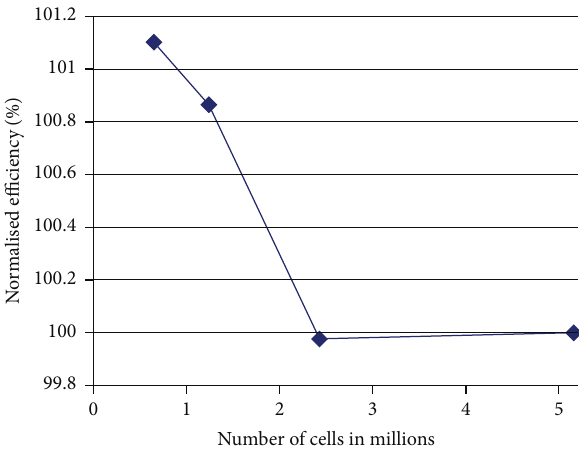
Figure 7: Runner efficiency response to mesh refinement.